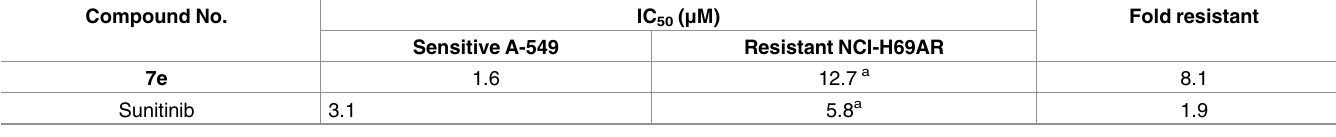
Table 5. Cancer cell growth inhibitory activity of compound 7e and sunitinib toward sensitive (A-549) and resistant (NCI-H69AR) cell lines. Compound No.